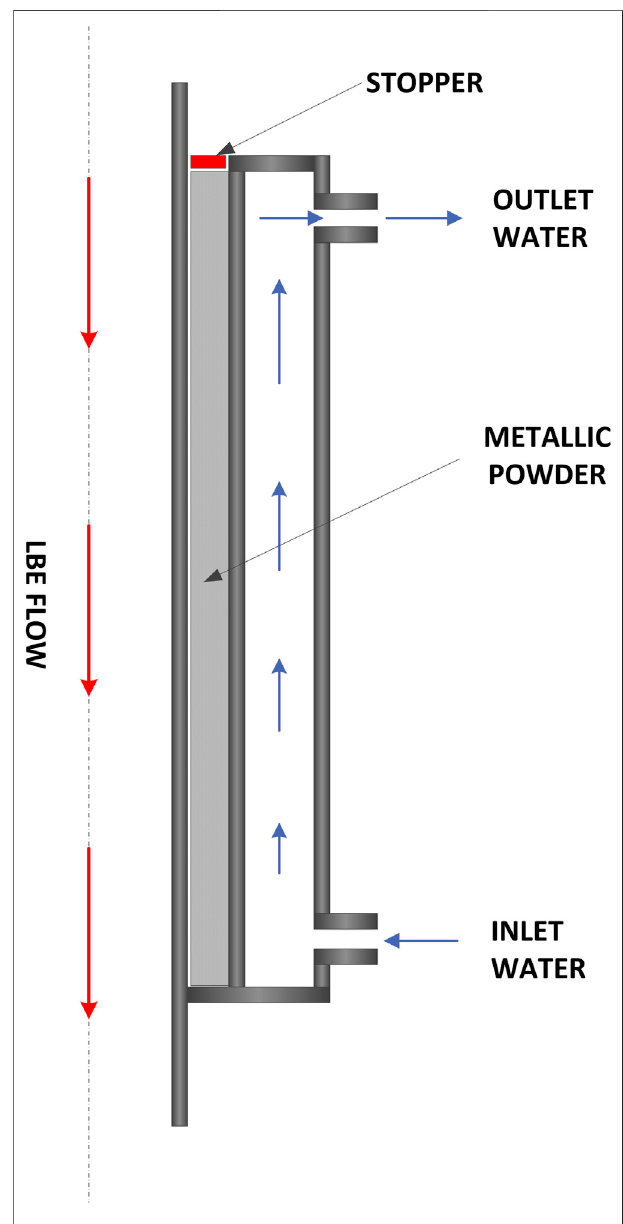
FIGURE 3 | View of the NACIE HX (Tarantino et al.,